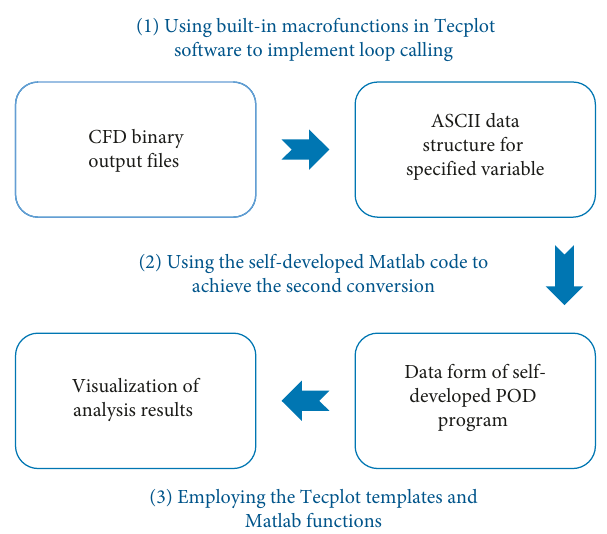
Figure 3: Interface program of data structure for the POD-CFD